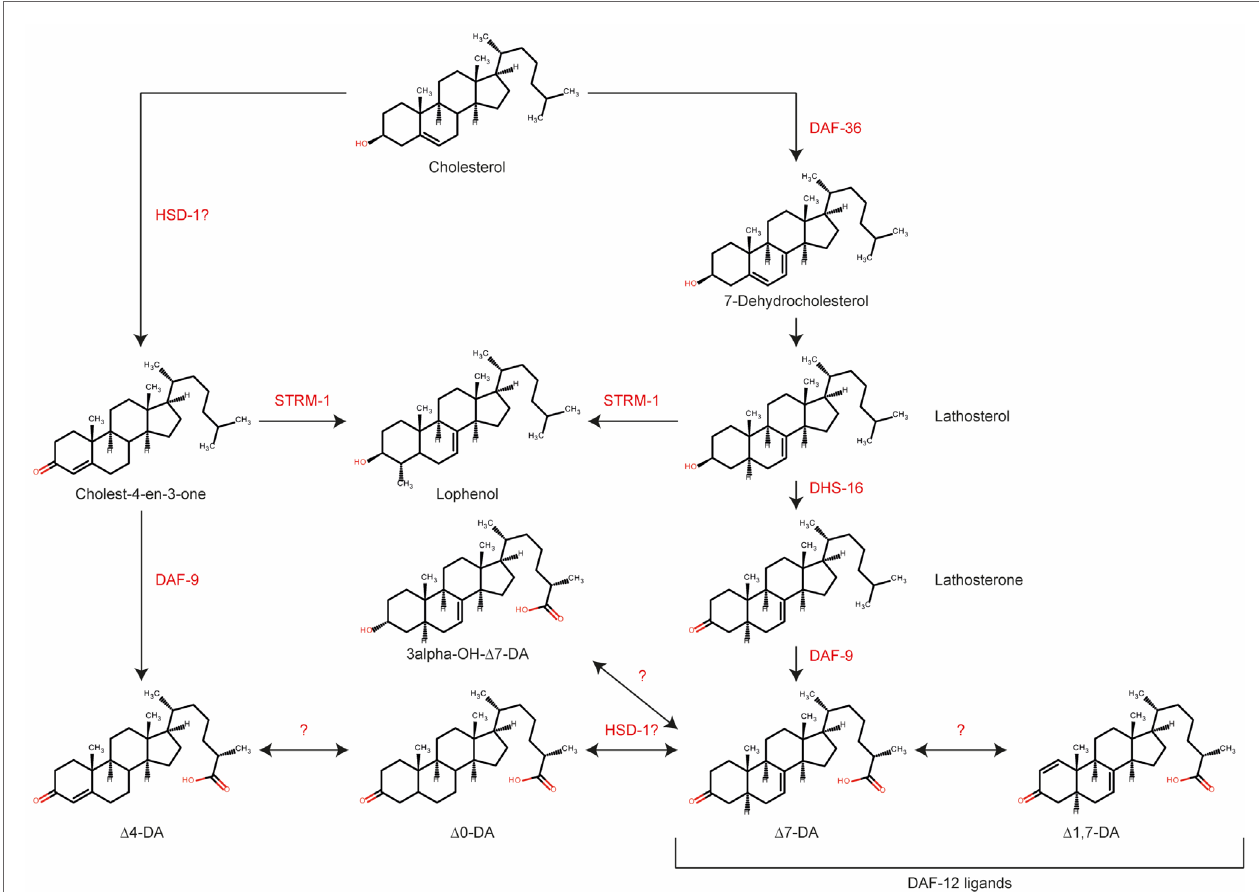
FiGURe 2 | Biosynthetic pathway for various dafachronic acids based on current knowledge . Several additional steroids and enzymes may exist. Adapted from Mahanti et al.